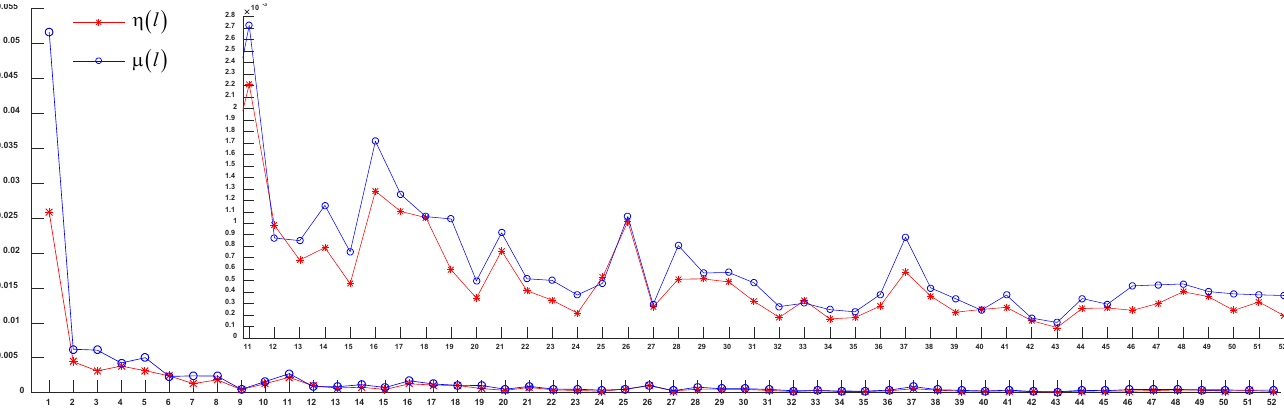
Fig. 5. Functions ( ) l η and ( ) l µ showing the progress of ratios in inequalities (15) and (16) for the example in Fig. 3. Both polylines decrease but not